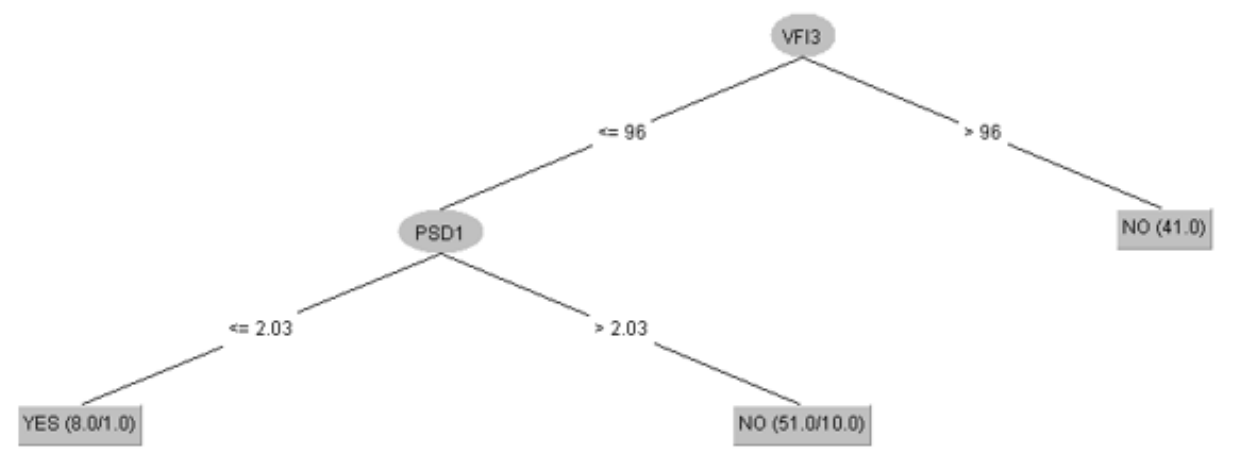
Figure 3. The decision tree generated by the C4.5 algorithm. Table 10. Confusion matrix for the MLP model.